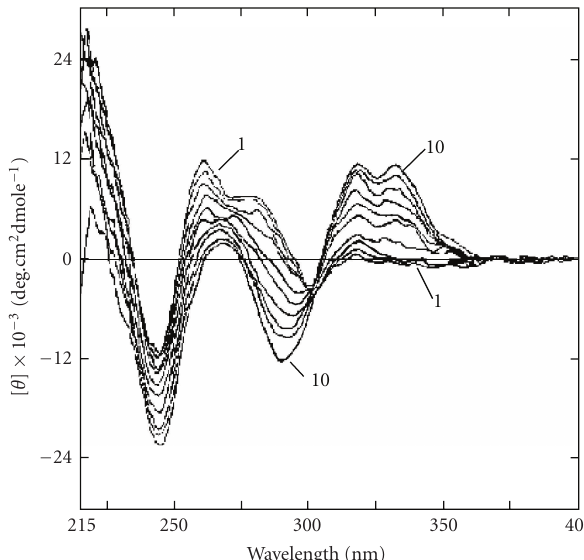
Figure 6: Circular dichroic spectrum of (1) H L -DNA (20 μ M) with increasing concentrations up to (20.64 μ M) of coralyne (10). Reprinted from the PhD Thesis of K. Bhadra,